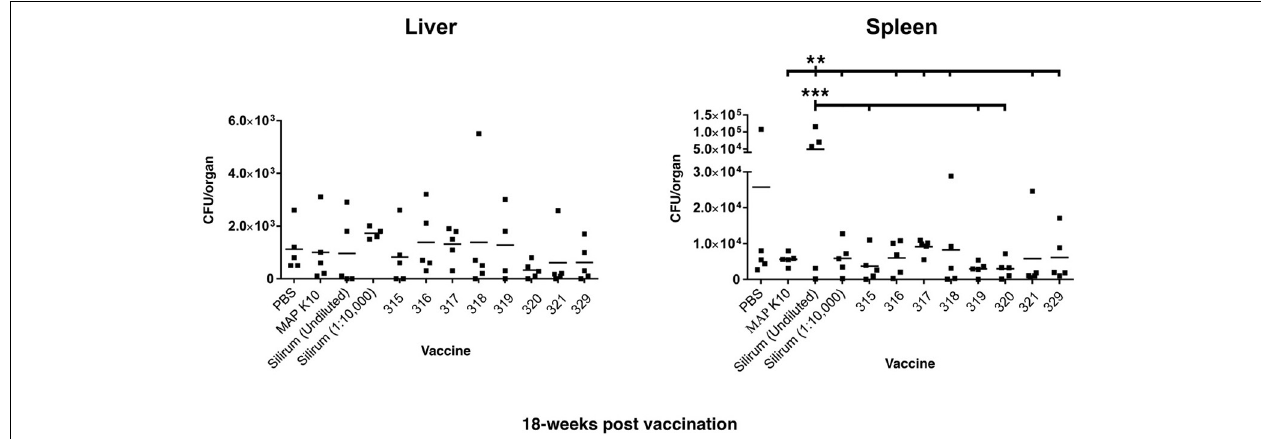
FIGURE 3 | MAP burden in liver and spleen at 18 weeks post vaccination. Two asterisks show statistical significance at P < 0 . 01 and three asterisks denote statistical significance at P < 0 . 001. The bar in each treatment represents the average of five mice.